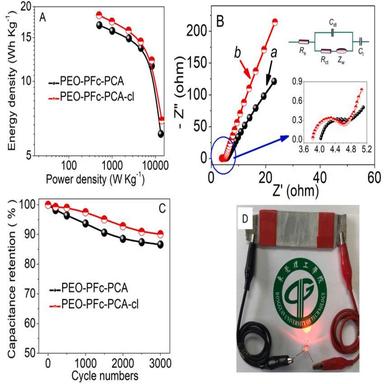
(A) Ragone plots of PEO-PFc-PCA before and after photo-crosslinking; (B) Nyquist electrochemical impedance spectra of PEO-PFc-PCA before and after photo-crosslinking with the inset showing the corresponding fitted equivalent circuit; (C) Capacitance retention comparison of PEO-PFc-PCA after 3000 constant current charge-discharge cycles at a current density of 50 A g-1 before and after photo-crosslinking; (D) Demonstration of an LED lighting powered by a supercapacitor composed of a photo-crosslinked PEO-PF